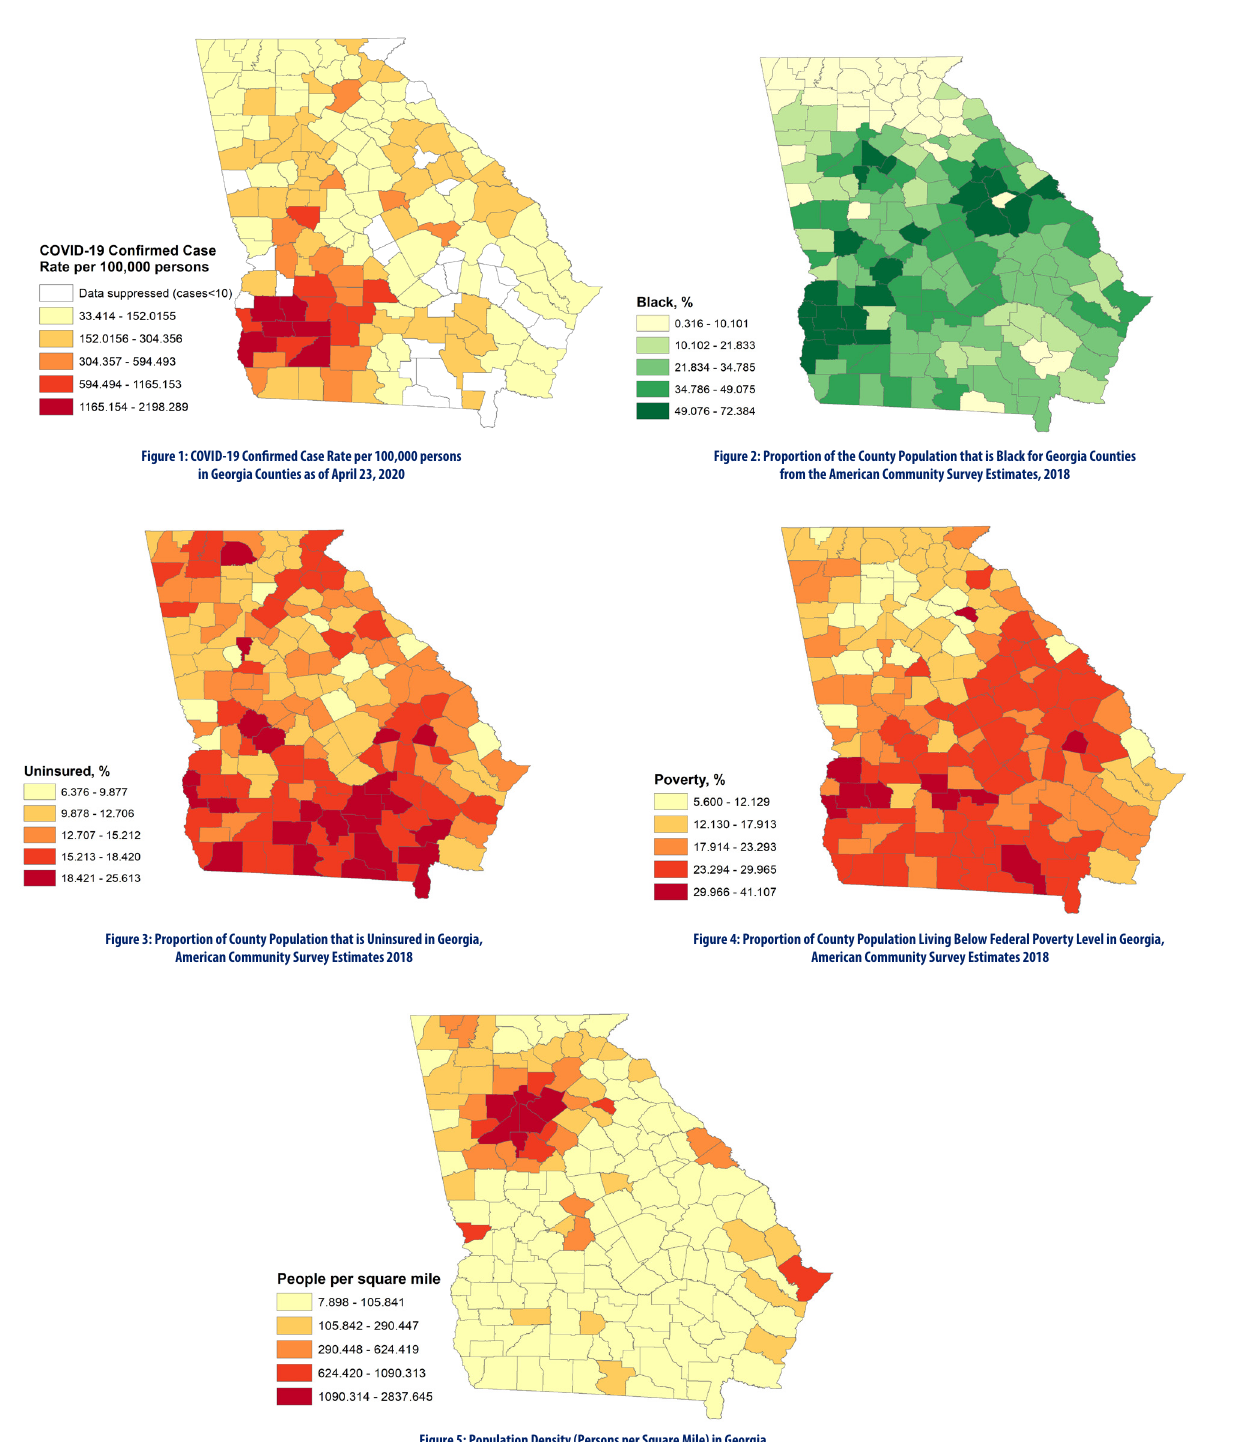
Figure 5: Population Density (Persons per Square Mile) in Georgia Coun ties , United States Census Bureau Estimates,